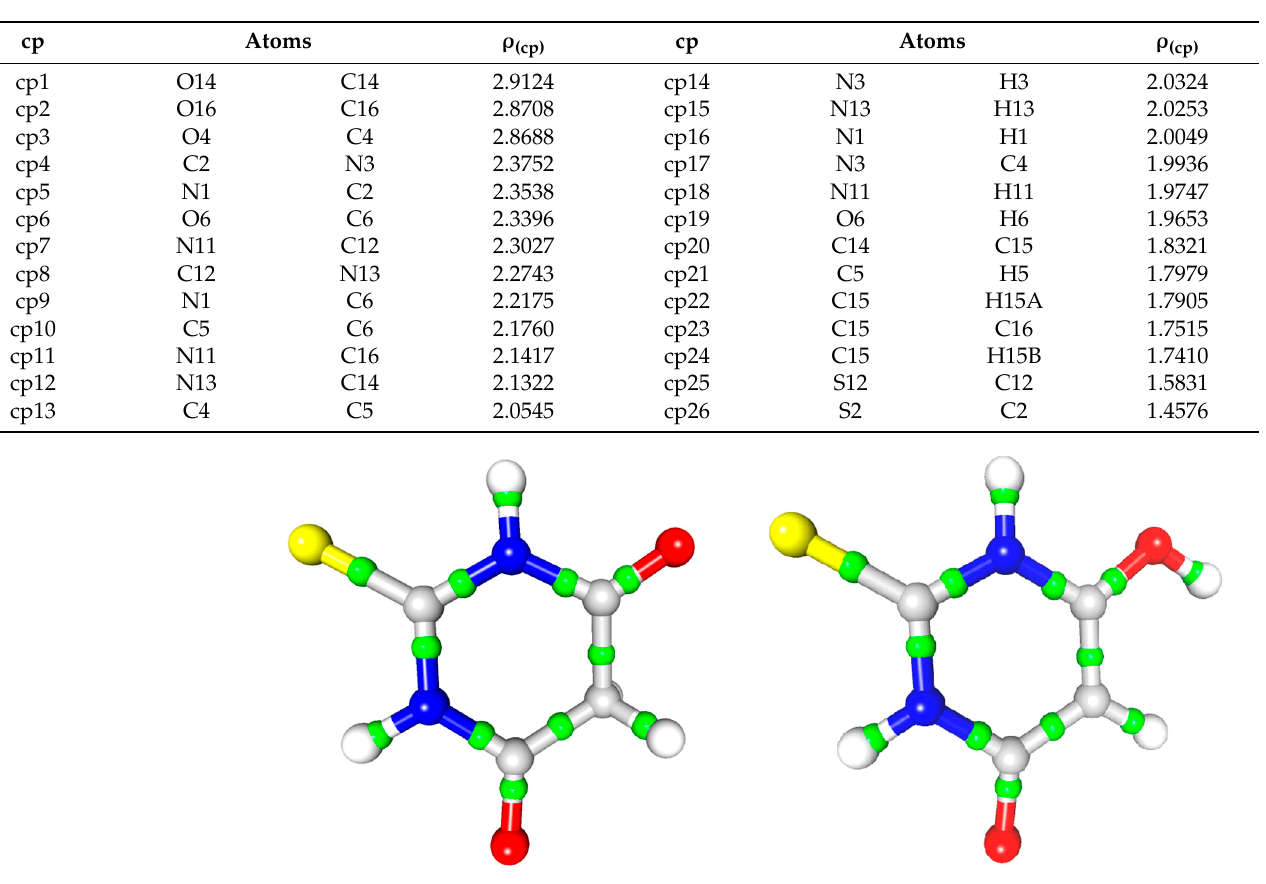
Figure 3. The intramolecular bond critical point (green balls) distribution in the two TBA tautomers: keto ( left ) and enol ( right ).